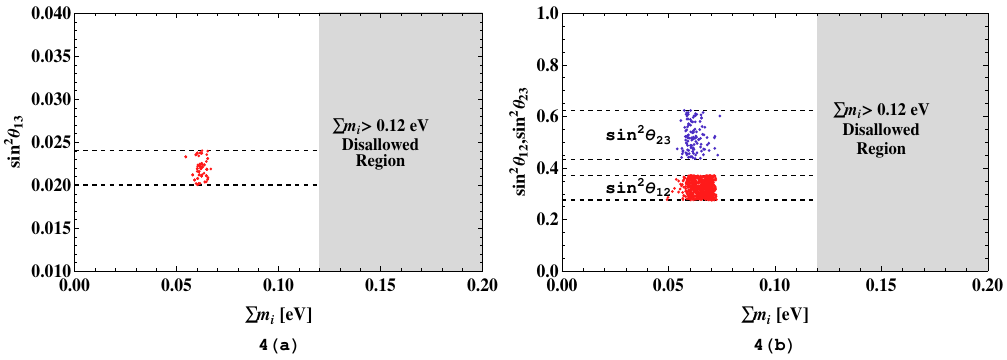
Figure 4 . Variation of neutrino mixing angles with sum of neutrino masses P m i for Normal hierar- chy. The grey shaded region is disallowed by cosmological bound on sum of neutrino masses [60, 61]. Horizontal lines represent 3 σ limits of respective mixing angle (table